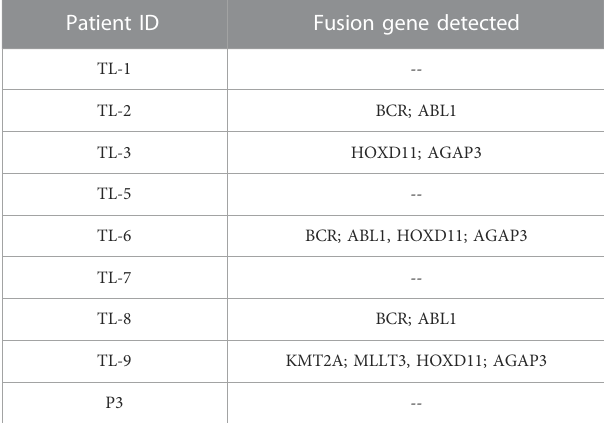
TABLE 2 Fusion genes detected in Indian Acute Leukemia Samples.